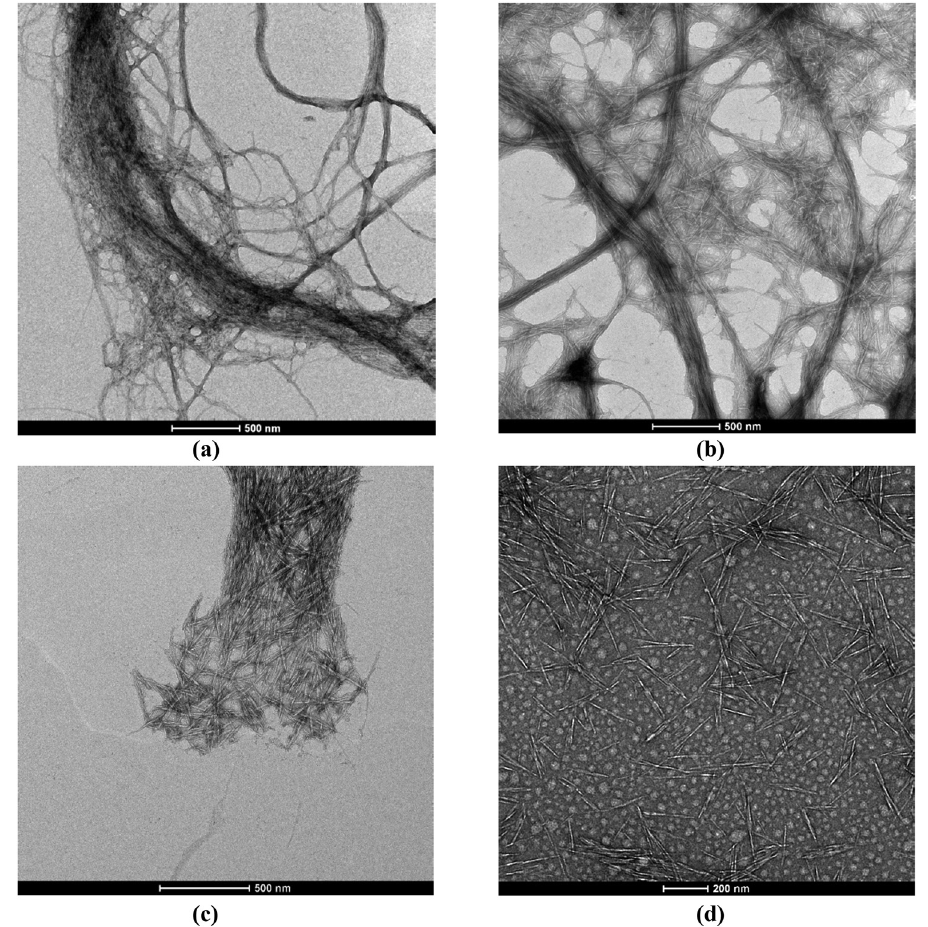
Figure 32: Morphology of CNFs: ( a ) before sonication and ( b ) after 30 min sonication; the morphology of CNCs: ( c ) before sonication and ( d ) after 30 min sonication, reprinted with permission from ref. [ 76 ] ; Copyright 2021, Elsevier